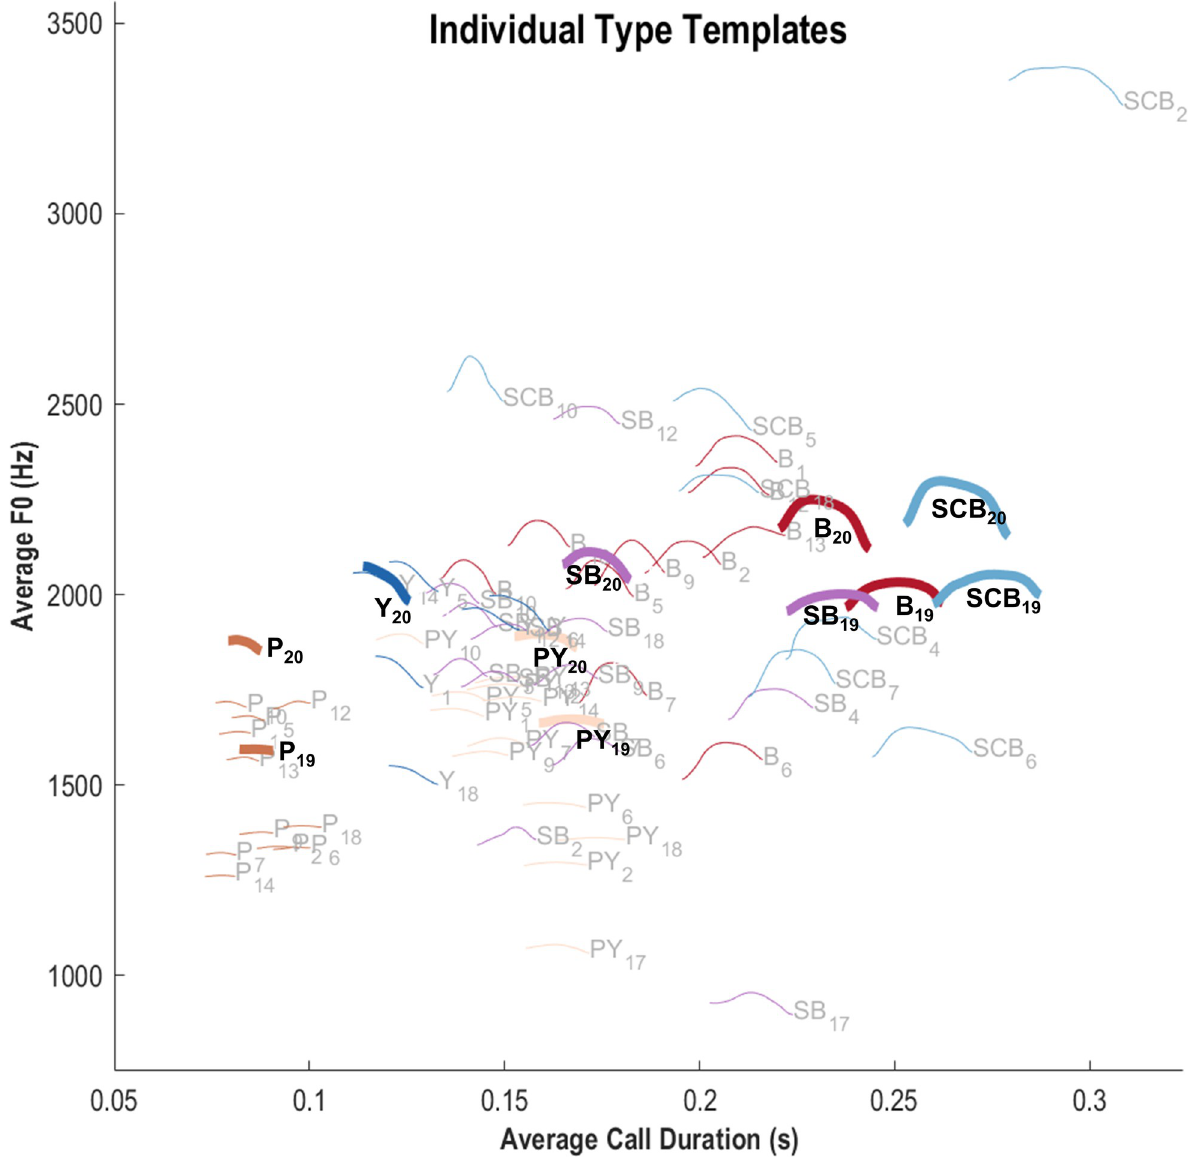
Fig 4. Representation of call f 0 templates at the individual level. Each color/hue combination corresponds to a call type (P, Y, PY, SB, B, SCB, as defined in Fig 3). Each curve is a miniature of an individual’s f 0 template. The call type (acronym and color) and individual identity (numerical index) are indicated. All individuals and call types for which at least 3 samples were available are displayed. The repertoire of individuals #19 and #20 is highlighted (thick